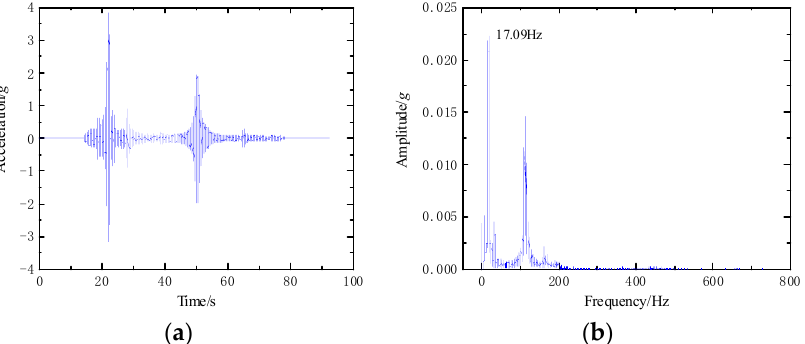
Figure 5. Modal parameter identification of structures: ( a ) time–history curve of acceleration and ( b ) frequency response curves of the structure.